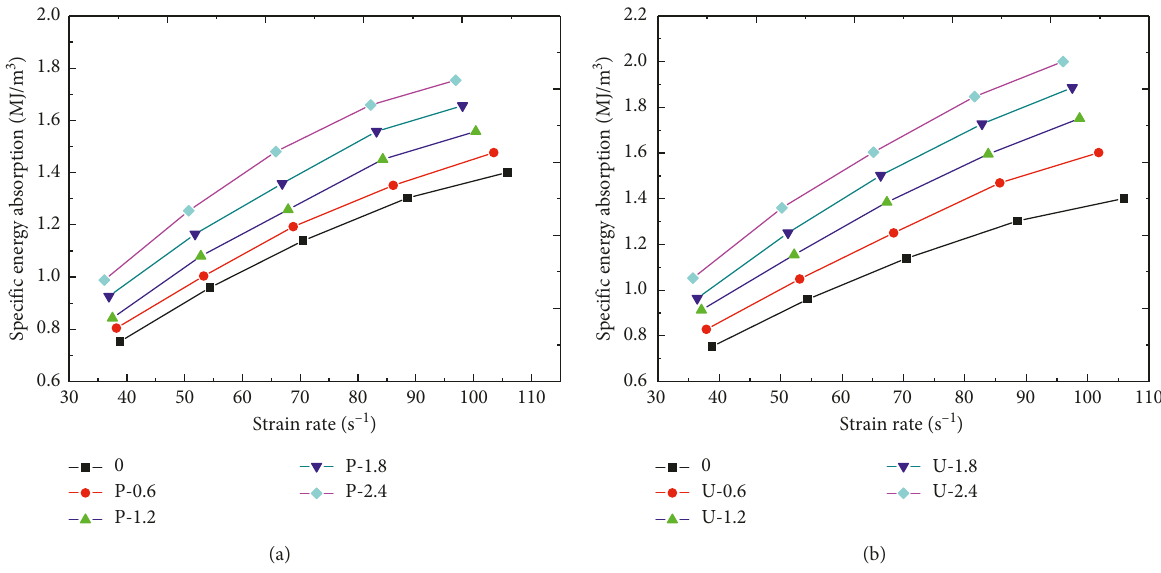
Figure 13: Relationship between strain rate and SEA of fiber-reinforced